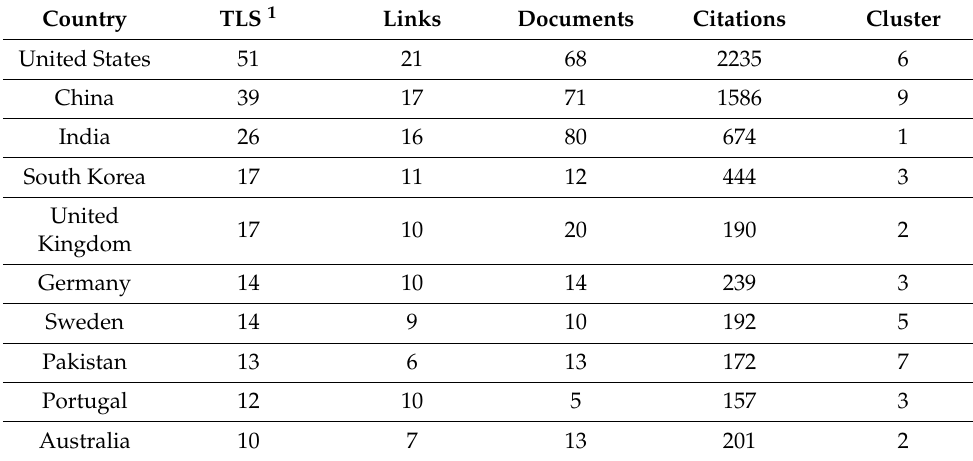
Figure 2. Flow diagram of the research process. Table 3. Document type from